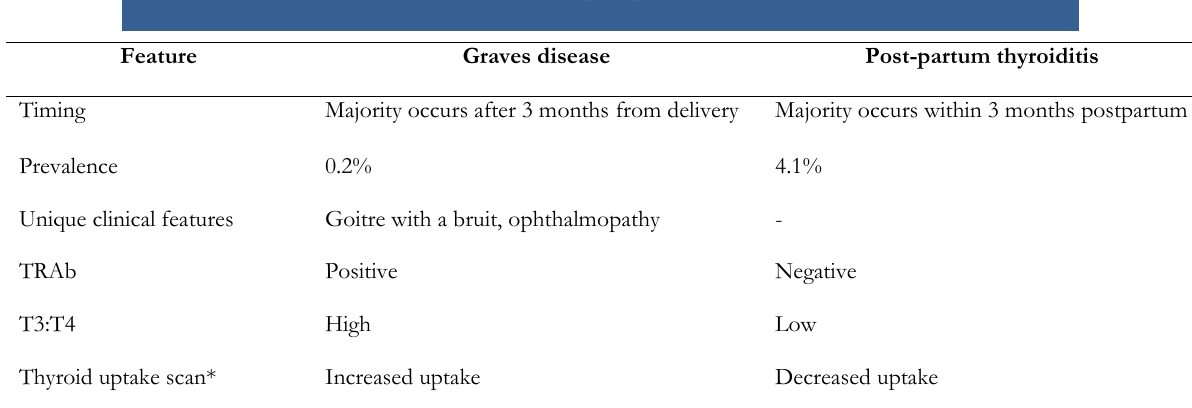
Table 4.9. Differentiation of post-partum thyroiditis and